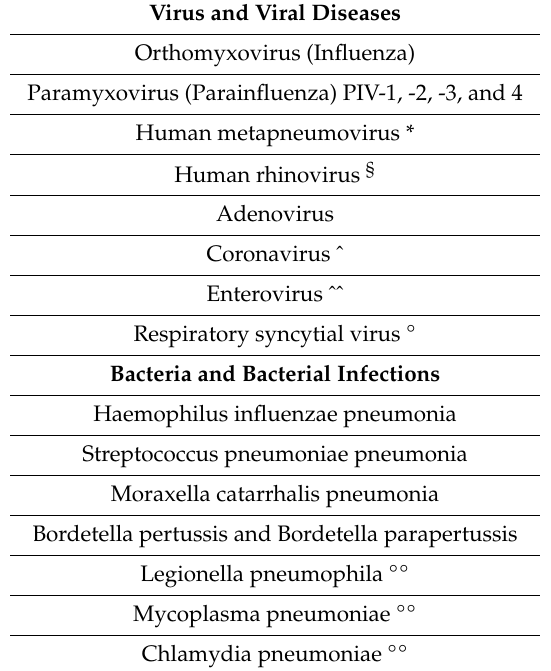
Table 1. Most common pathogens and respiratory diseases that may display symptoms similar to coronavirus diseases (COVID)-19 include the